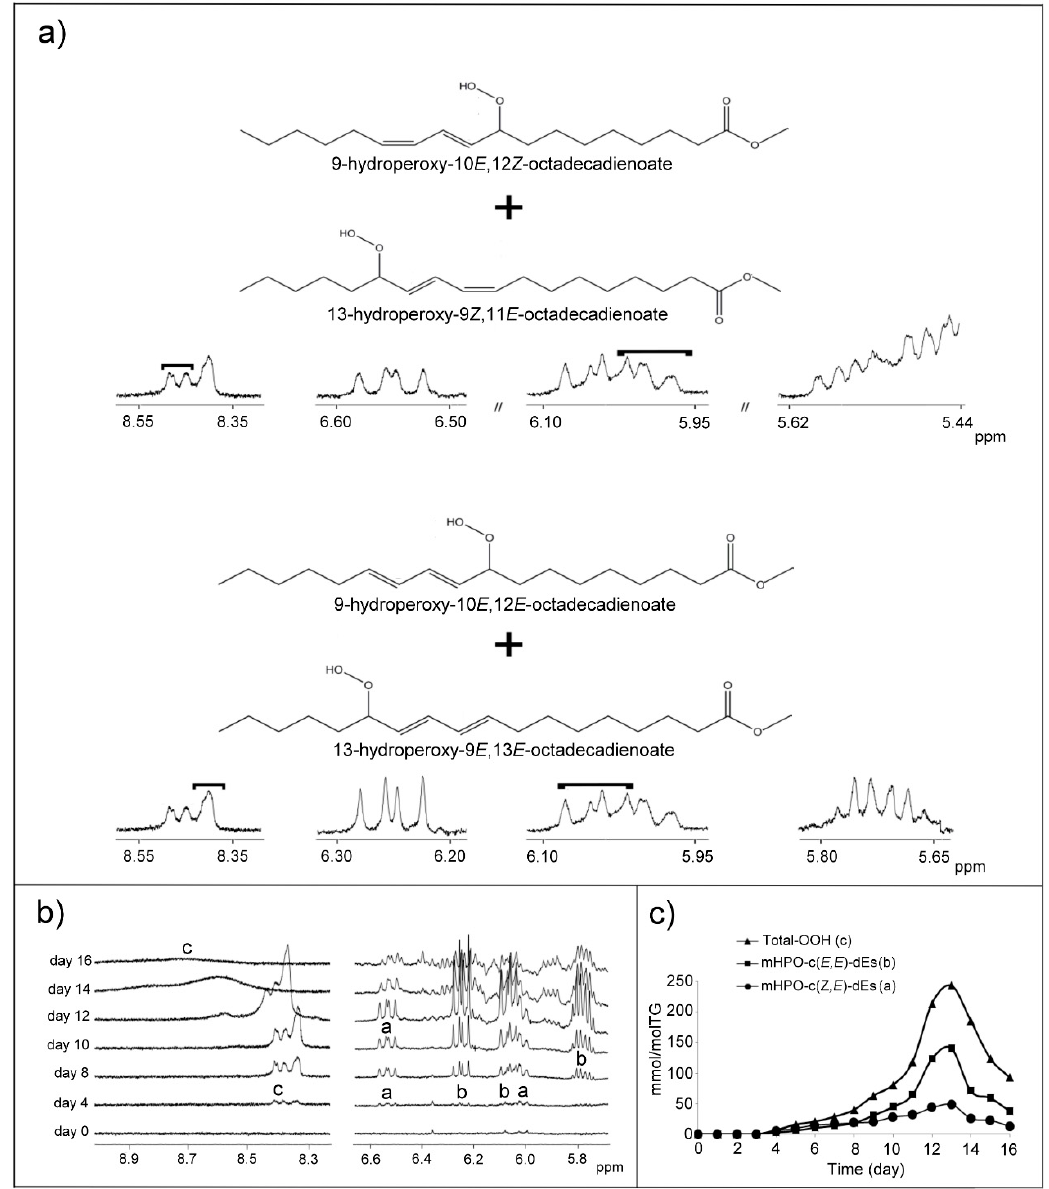
Figure 2. ( a ) Chemical structure of the monohydroperoxy-conjugated dienes (mHPO-c-dEs) detected in corn oil submitted to oxidative conditions, together with the enlargement of some regions of the 1 H NMR spectra in which the signals of monohydroperoxy-conjugated dienes appear. ( b ) Enlargements of some spectral regions between 5.8 and 6.6 ppm and 8.3 and 8.9 ppm, where changes occur throughout the oxidation process and their evolution with time. ( c ) Evolution of the concentration of mHPO-c( Z,E )-dEs, mHPO-c( E,E )-dEs and Total-OOH, expressed as mmol / mol TG versus time given in days.